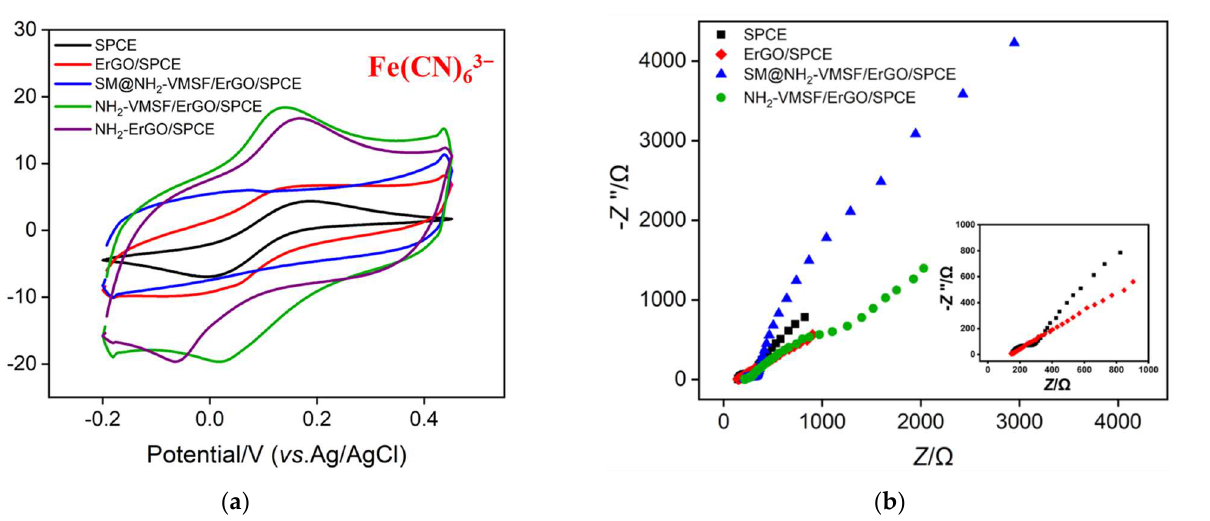
Figure 2. ( a ) Cyclic voltammetry (CV) curves obtained on different electrodes in 0.05 M KHP con- taining 0.5 mM Fe(CN) 63− . ( b ) EIS curves obtained on different electrodes. The electrolyte solution is containing 0.5 mM Fe(CN) 63 − . ( b ) EIS curves obtained on different electrodes. The electrolyte 2.5 mM Fe(CN) 63−/4− containing 0.1 M KCl, The inset is the magnified EIS plots on SPCE and solution is 2.5 mM Fe(CN) 63 − /4 − containing 0.1 M KCl, The inset is the magnified EIS plots on SPCE ErGO/SPCE. and